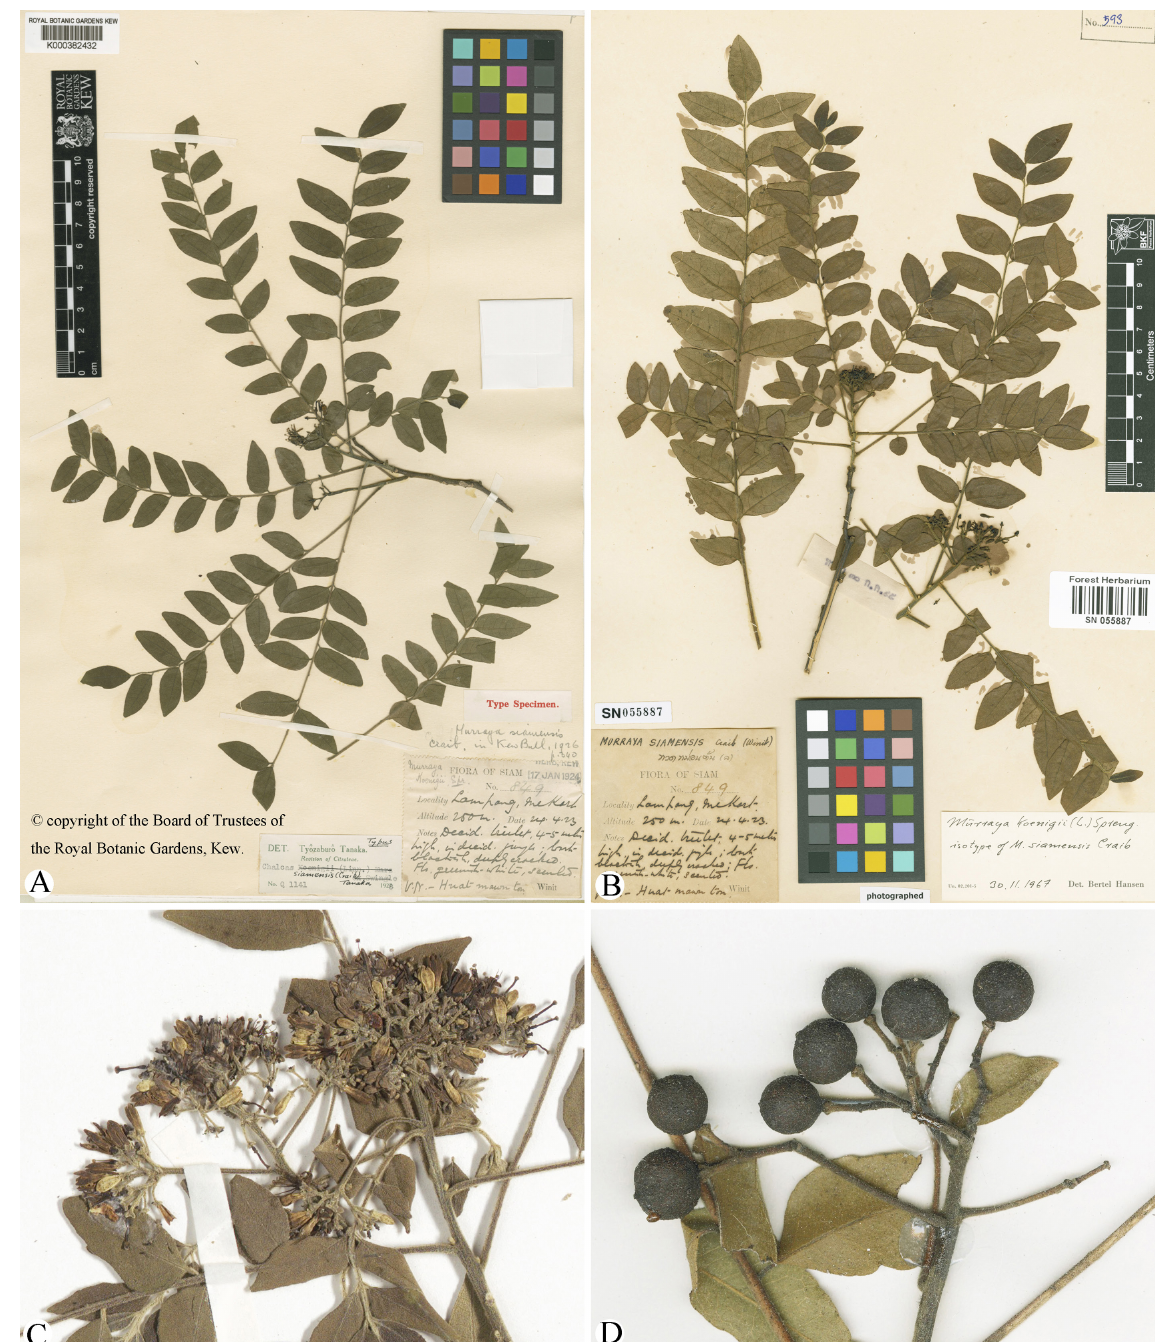
Fig. 11. Branches, leaves, flowers and fruits of Bergera siamensis (Craib) F.J.Mou comb. nov. A . Winit 849 , K000382432 (holotype: the Kew Herbarium, K). B . SN055887 (isotype: Bangkok Forest Herbarium, BKF). C . D.D. Soejarto et al. 5834 , L.2127107 (National Herbarium Nederland, Leiden University branch, L). D . Put Nai 2440 , TCD0013457 (Trinity College Dublin Herbarium,